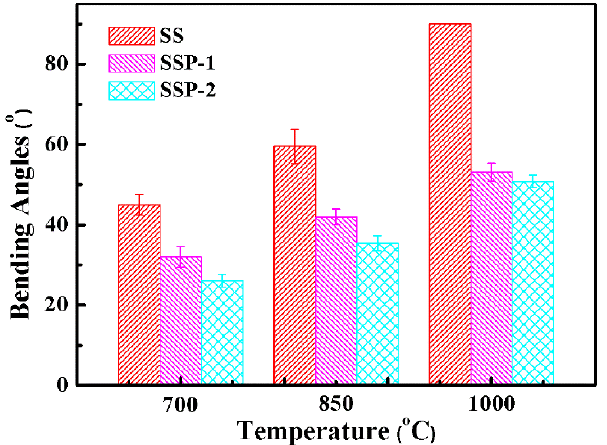
Figure 3. Bending angles of all samples fired at different temperatures for 30 min.